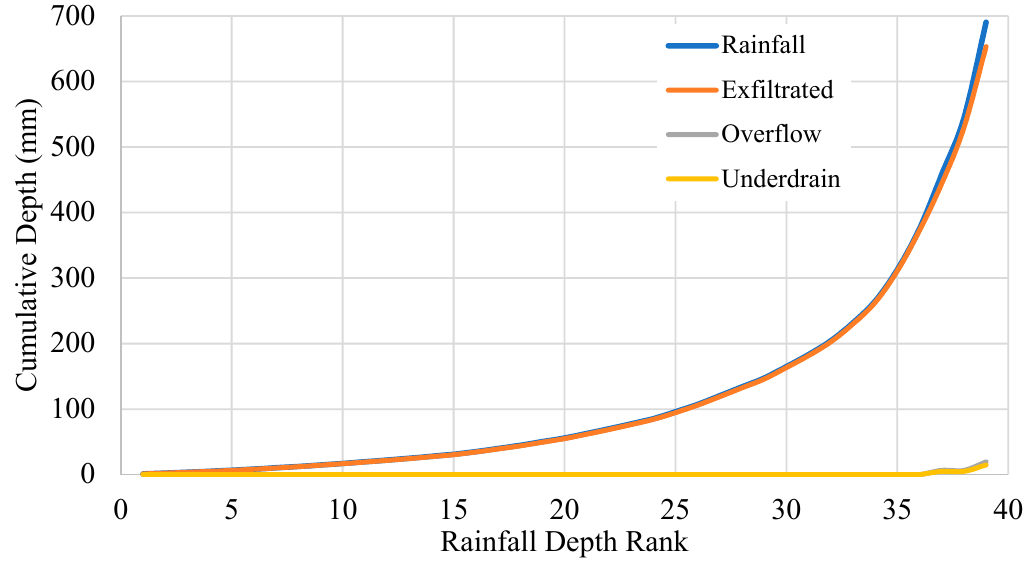
Figure 6. Distribution of rainfall into overflow, underdrain, and exfiltration.